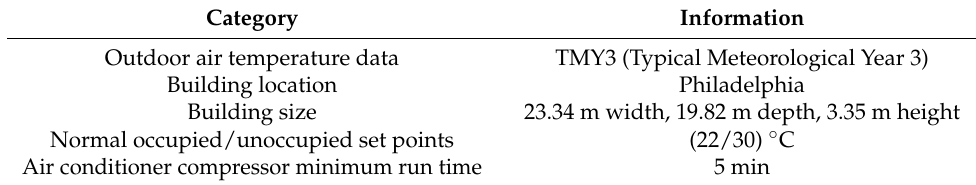
Table 3. The simulation building